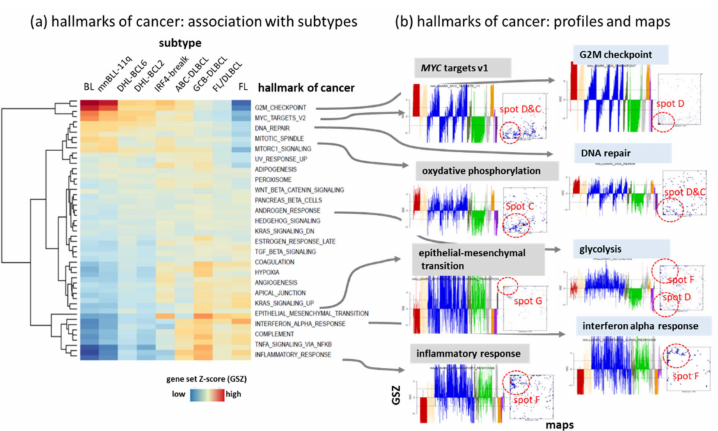
Figure A4. Functional associations of the subtypes and of the spot modules with gene signatures taken from the category “hallmarks of cancer” [86]. ( a ) BL and BL-resembling subtypes show high expression of functions related to cell cycle activity, DNA-repair and MYC -targets, while inflammatory and stromal characteristic are upregulated in DLBCL and, partly, FL. ( b ) The profiles reveal a more detailed pattern. Not that the tumors in each subtype are ranked with increasing cell cycle activity (using the literature gene set [85]) resulting partly in “ramp-like” silhouettes which reflect variance of expression as a result of changing cell cycle activity. The gene set maps show the distribution of the signature genes in the SOM. Theirs accumulation in around the spot-areas is indicated by red